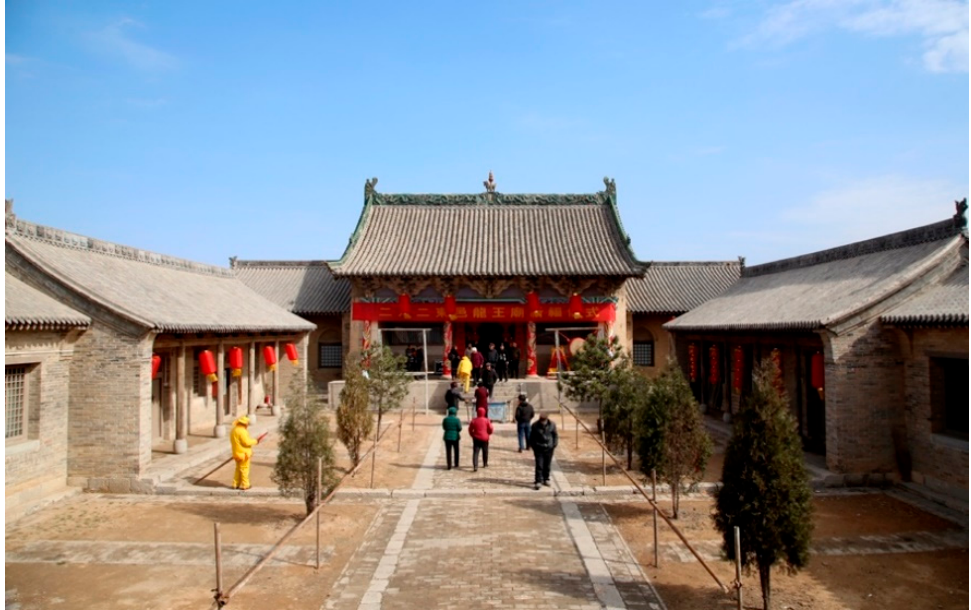
Figure 4. The second courtyard of Longwang Temple (© Lui Tam).